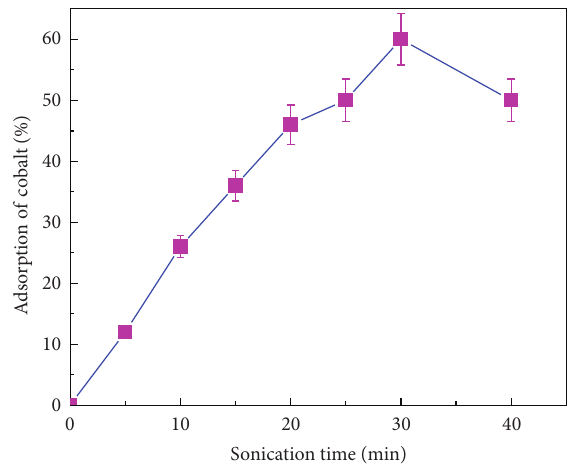
F 2: e effect of sonication times on the removal of Co